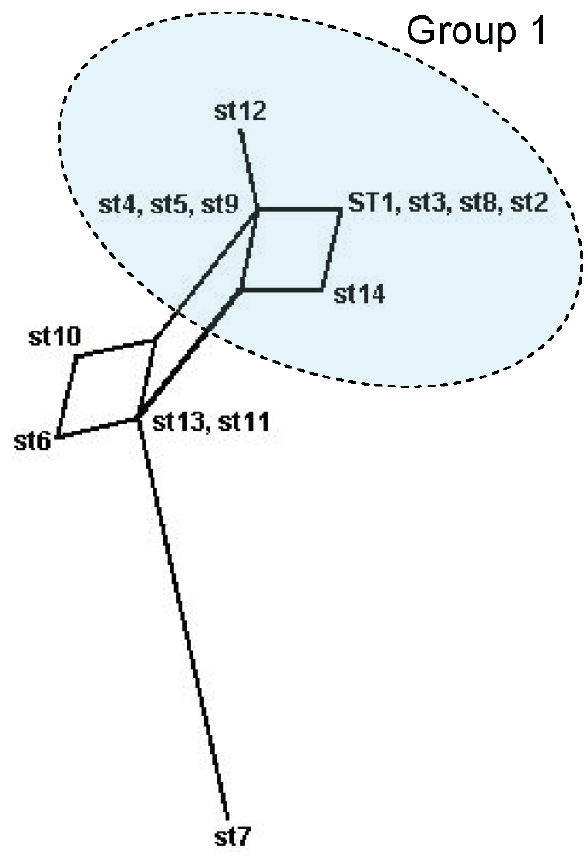
Figure 5. Splits decomposition was used to detect evidence for a past history of recombination in the sequences. The extensive reticulation suggests that recombination has occurred relatively frequently. However, Group 1 remains distinct (as indicated by the filled oval).